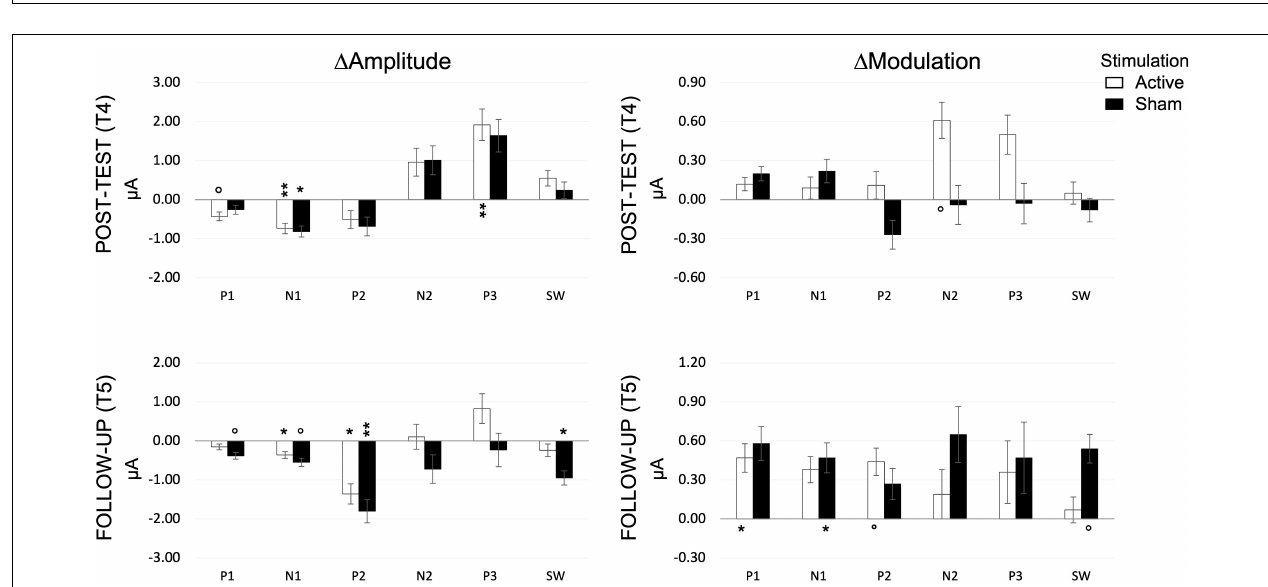
FIGURE 9 | Amplitude of ERP for each LOAD ( n = 2, n = 3, and n = 4), TIME (T0, T4, and T5) and component.